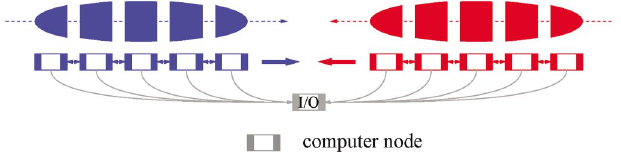
FIG. 1. (Color) Parallel scheme of SBBE . One MPI node is used to represent one slice. A slice exchanges macroparticles with the adjacent ones at IP, and then collides in turn with the ones in the other bunch. The I/O node is used to collect data and save them to a file. The computing time increases linearly by a factor of (cid:1) n (cid:2) 1 (cid:3) , where n is the number of slice in one bunch.